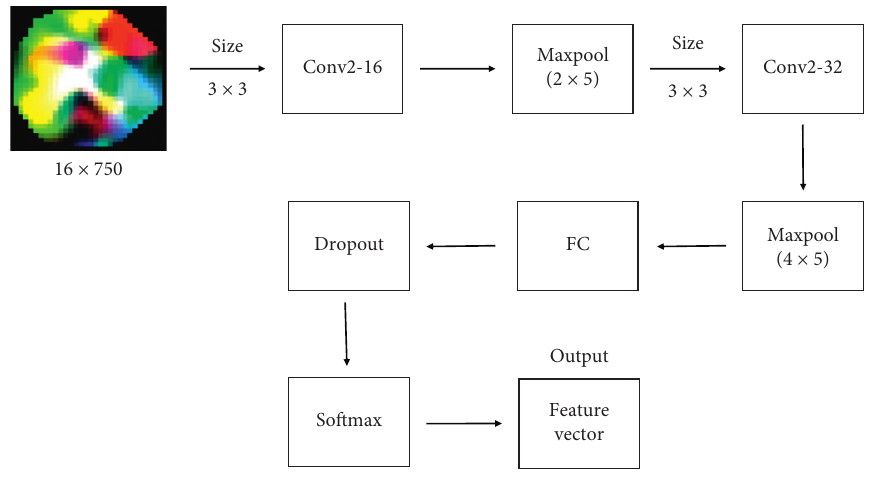
Figure 4: CNN in the CSP-CNN model. Table 1: Main parameters of the CNN model used to classify data after CSP dimensionality reduction.